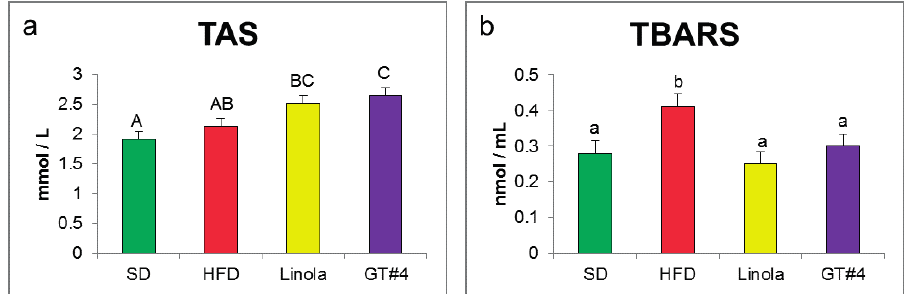
Figure 2. The effect of the experimental diet consumption on the red-ox state indices. ( a ) TAS (total antioxidant status); ( b ) TBARS (thiobarbituric acid reactive substances). The error bars indicate the SEM. Significant effect: values that do not share a common small letter (a,b) differ significantly at the level p < 0.05, and values that do not share a common capital letter (A,B,C) differ significantly at the level p <